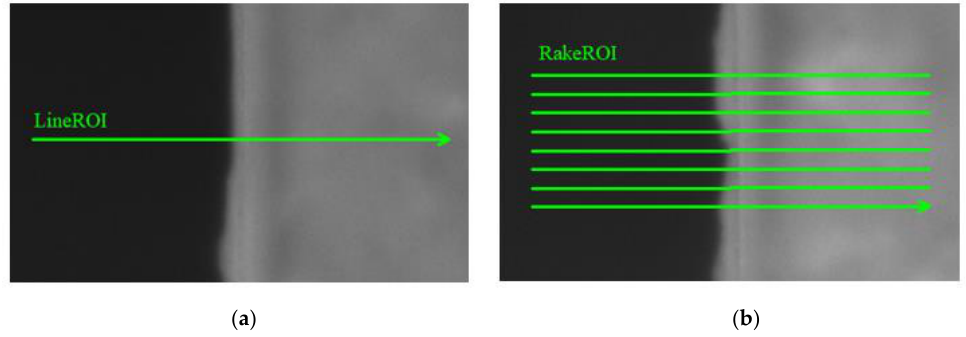
Figure 6. Diagram of ROI style: ( a ) the style of Line ROI; ( b ) the style of Rake ROI.